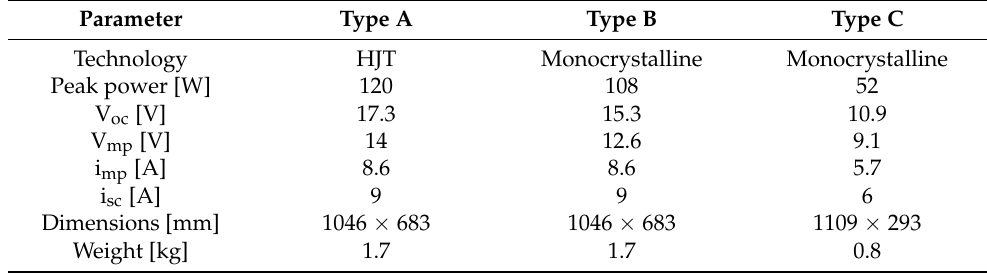
Table A3. Characteristics of each type of photovoltaic panel simulated within the energy